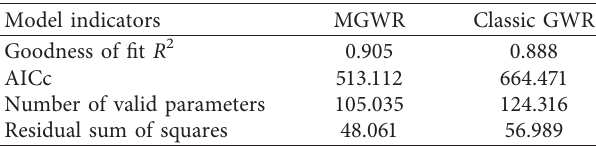
Figure 2: LISA map of unit price of second-hand housing in Binhu New District. Table 3: Indexes of classical GWR and MGWR